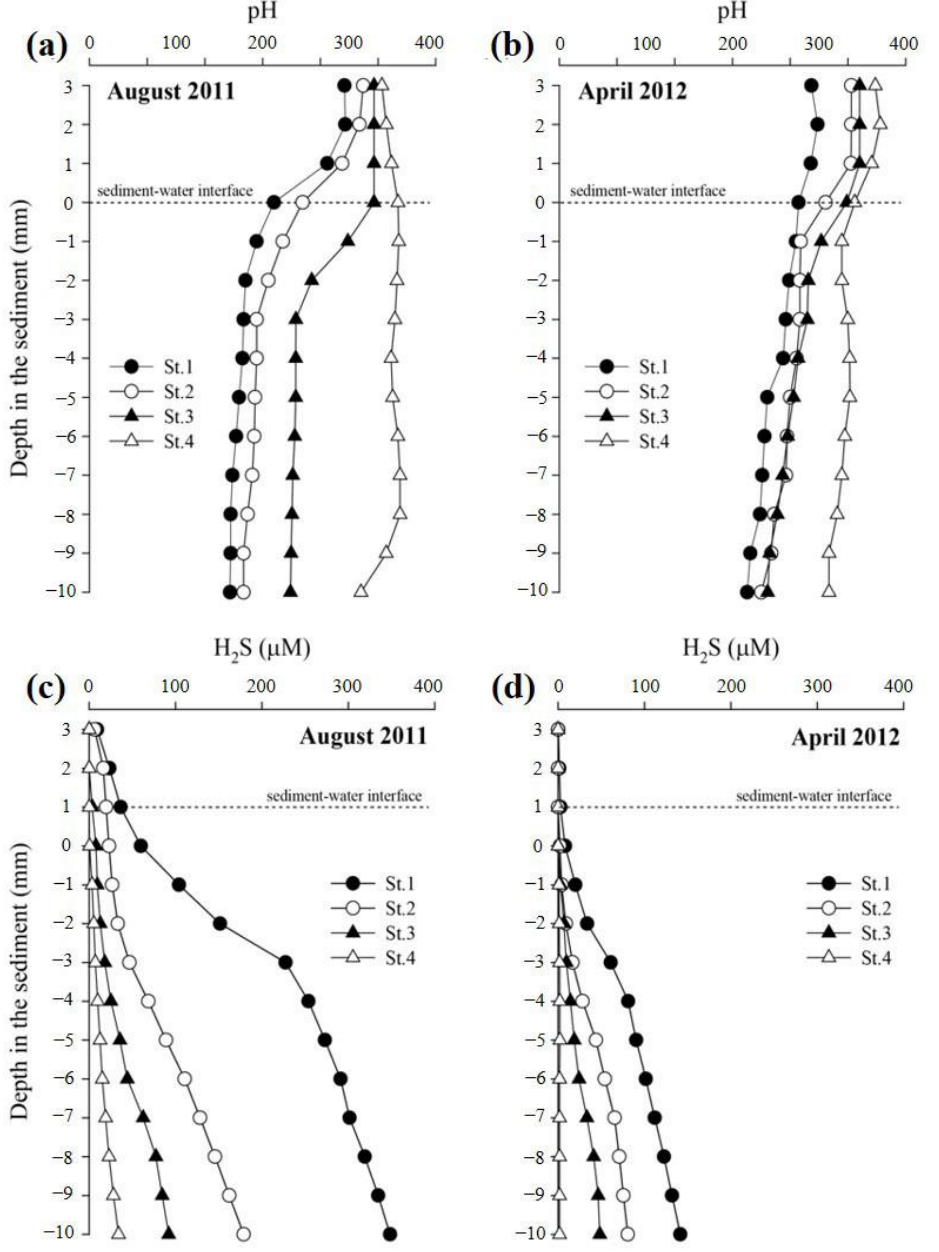
Figure 4. Profiles of the pH and H 2 S measured in the sediment of Masan Bay during August 2011 and April 2012. ( a ) pH (August 2011), ( b ) pH (April 2012), ( c ) H 2 S (August 2011), and ( d ) H 2 S (April 2012).